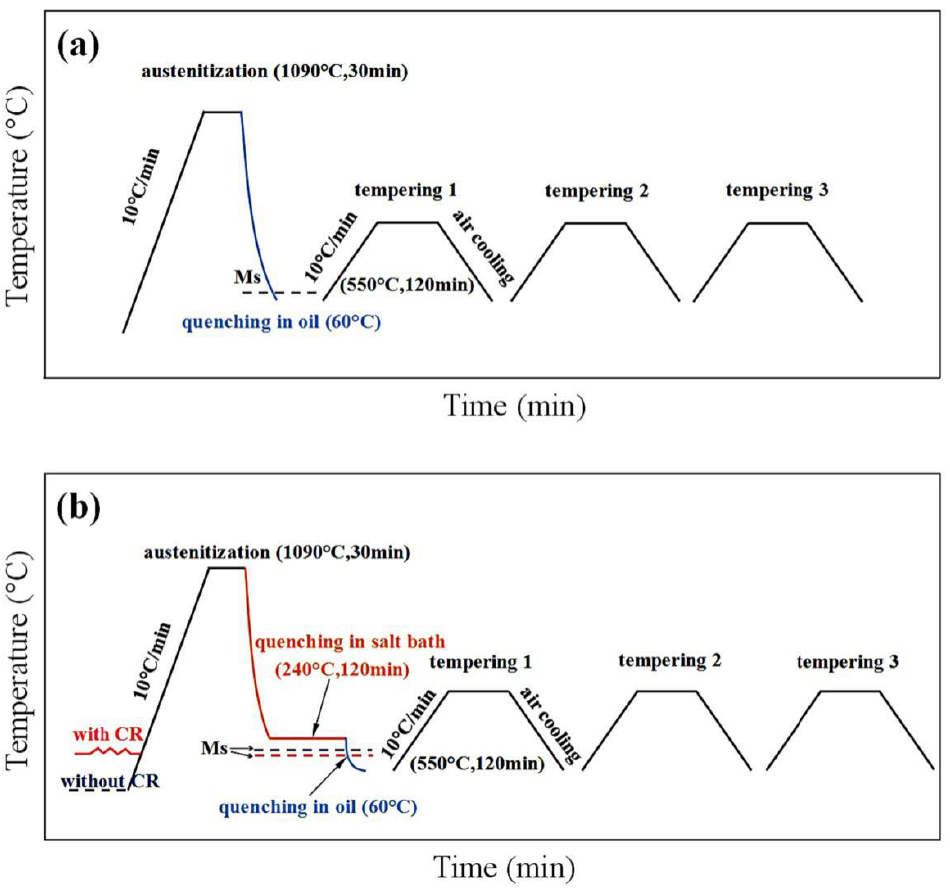
Figure 1. Schematic diagrams of the heat treatment processes: ( a ) Q-T process; ( b ) austempering process without and with CR. (Q-T: martensite quenching-tempering; CR: cold rolling).